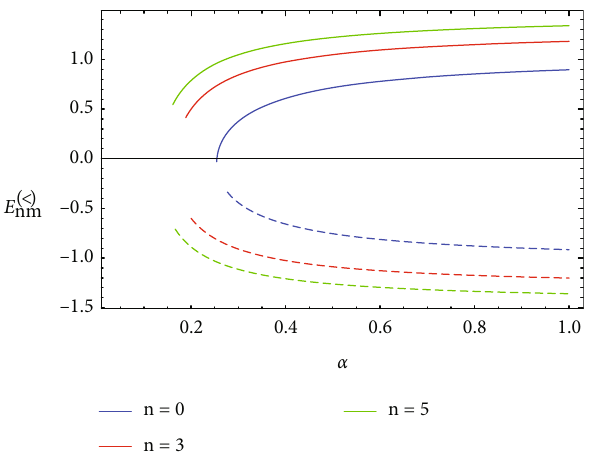
Figure 6: Sketch of the energy (Equation (71)) as a function of α for m = 1 , B = 0 : 1 , a = 0 : 1 , ϕ = 0 : 1 , and di ff erent values of n . For values of α smaller than 0 : 25 , the energy level E 0,1 (blue line) is nonpermissible. The same occurs with the energy levels E 3,1 (red line) and E 5,1 (green line), where they are permissible only for α > 0 : 19 and α > 0 : 16 ,